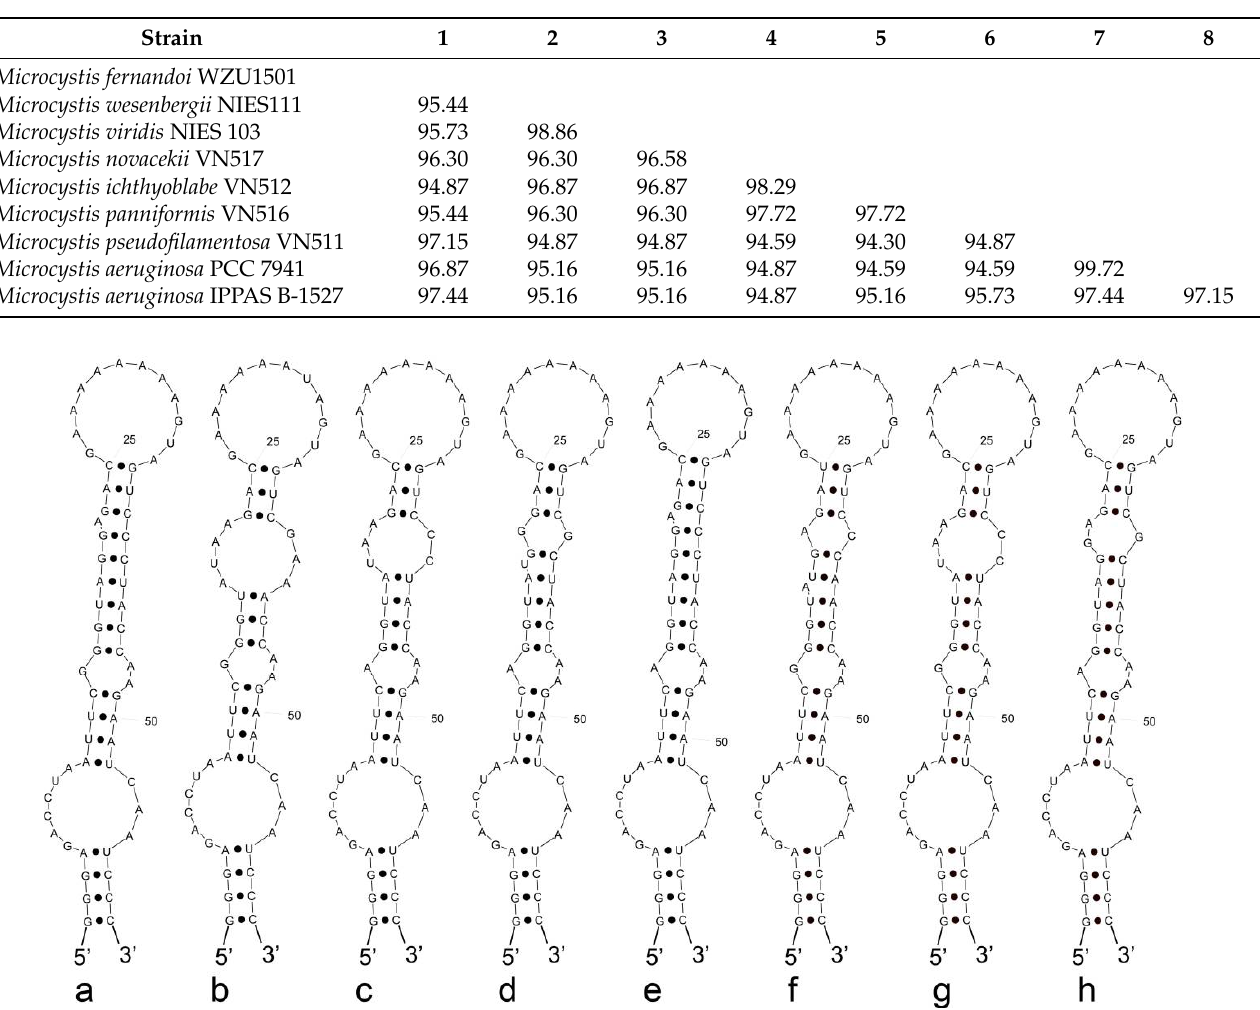
Figure 5. Box–B helices and V3 helices of Microcystis . ( a ). Box–B helix of WZU1501 and Microcystis ichthyoblabe VN512. ( b ). Box–B helix of Microcystis wesenbergii NIES111. ( c ). Box–B helix of Microcystis viridis NIES 103 and Microcystis pseudofilamentosa VN511. ( d ). Box–B helix of Microcystis novacekii VN517 and Microcystis panniformis VN516. ( e ). Box–B helix of Microcystis aeruginosa PCC 7941. ( f ). Box–B helix of Microcystis aeruginosa IPPAS B-1527. ( g ). V3 helix of all strains. 4. Discussion Cyanobacterial blooms dominated by Microcystis species have frequently been docu- mented worldwide [7,31]. Thus, the correct identification of Microcystis species has be- come an important basis for further monitoring of the blooms. Currently, more than 50 species of the genus Microcystis are taxonomically accepted [6]. Six morphospecies, such